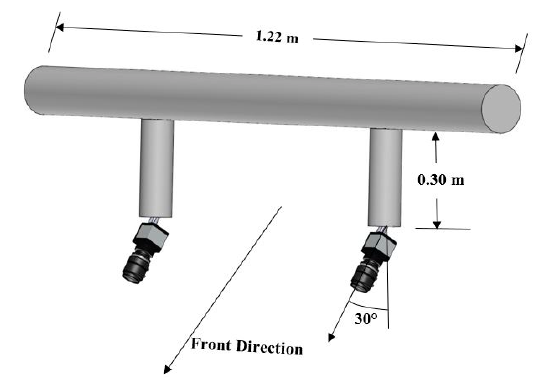
Figure 3. Camera setup for image acquisition during field experiments.